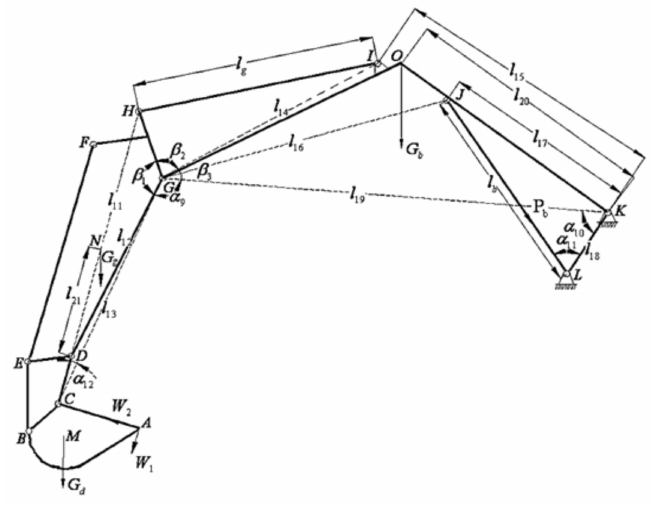
Figure 2. The geometric parameters of the working beam of the hydraulic excavator. ABC-bucket; BE-connecting rod; DE-rocker CDG-bucket arm; EF-bucket cylinder; HI-bucket arm cylinder; GOJK- swing beam; JL-beam cylinder.